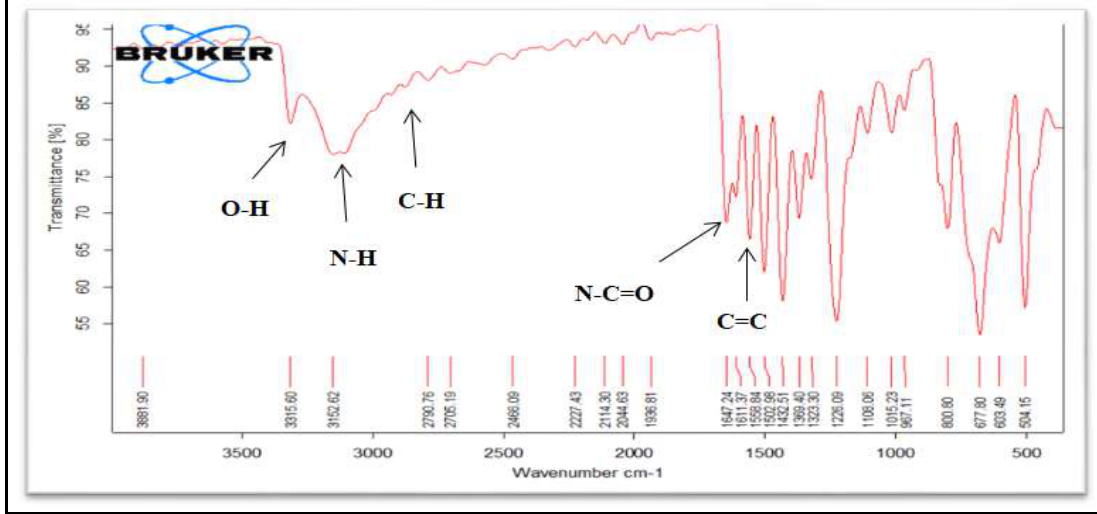
Figure 2. FTIR spectrum of paracetamol.